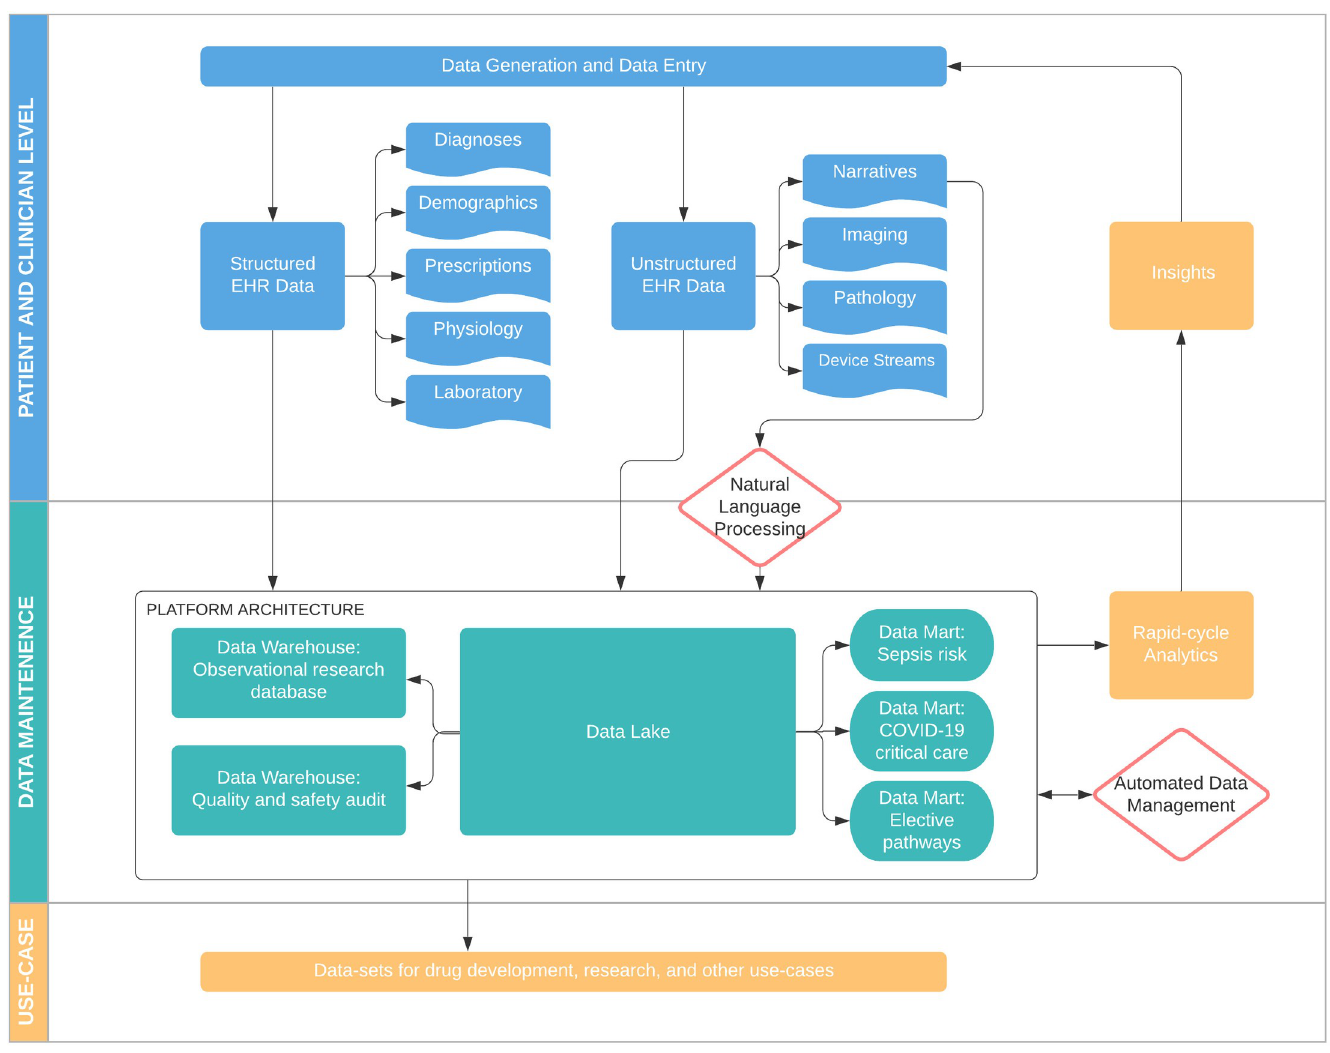
Fig 2. An example data platform incorporating multiple best practices discussed in this article including natural language processing, generation of data warehouses and data marts, and ADM. ADM, augmented data management; COVID-19, Coronavirus Disease 2019; EHR, electronic health